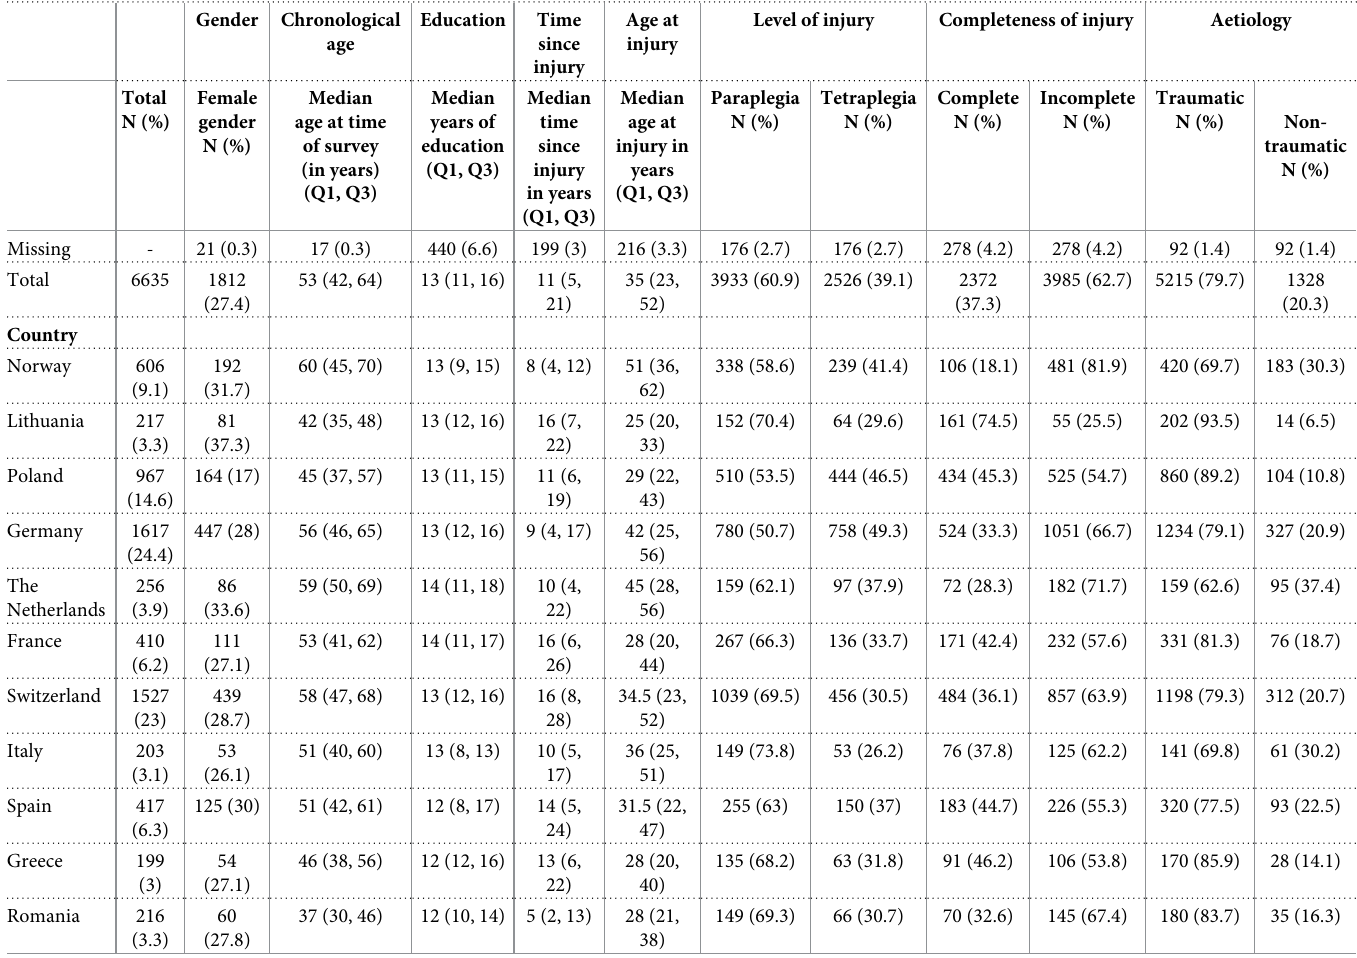
Table 1. Basic sociodemographic and lesion characteristics of European country study participants by collaborating